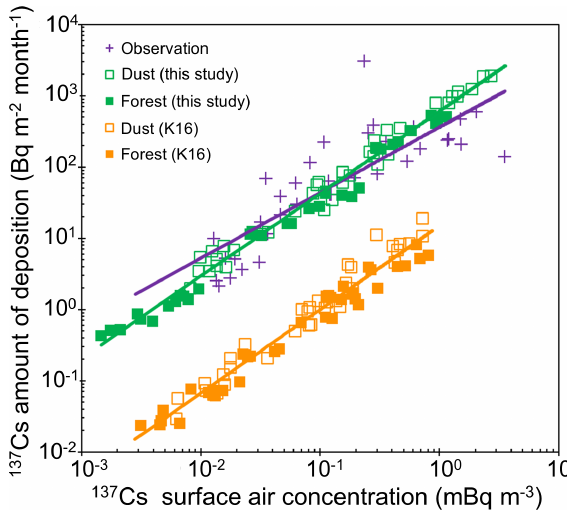
Figure 2. Scatter diagram of the depositions of 137 Cs over the monthly mean (purple crosses) observed surface concentrations at Namie (Tsushima), Fukushima, and Tsukuba in 2013 and those simulated by Kajino et al. (2016) (K16) ( E c and v d are 0.04 and 0.1cms − 1 , respectively) considering different emission sources: the open orange squares represent mineral dust particles from bare soil (dust aerosols), and the closed orange squares denote bioaerosols emitted from forest ecosystems (forest aerosols). The green open and closed squares are the same as the orange squares but are simulated by this study ( E c and v d are 0.4 and 10cms − 1 , re- spectively). The purple, orange, and green lines indicate the regres- sion lines of the purple crosses, orange squares (open plus closed), and green squares (open plus closed),